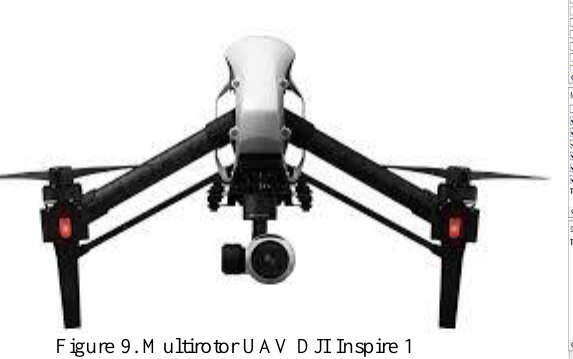
Figure 8. Xenmuse X3 Camera